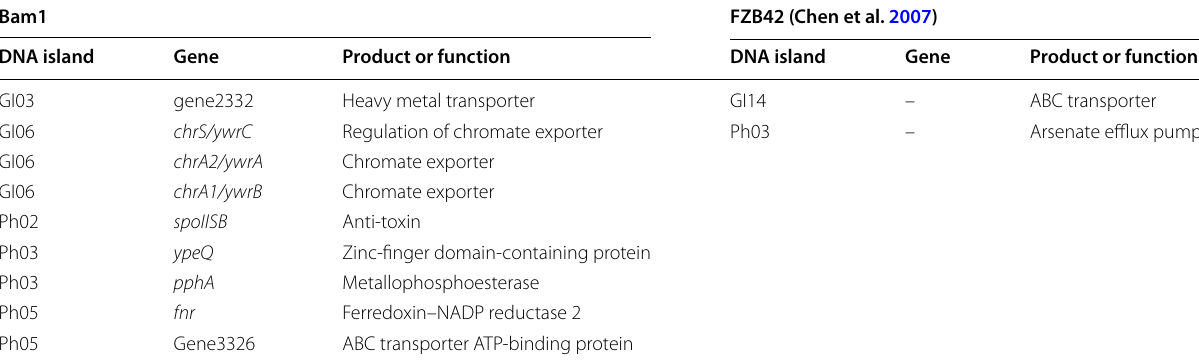
Table 2 Genes involved in heavy metal resistance in the genomic islands (GIs) and prophages (Phs) of the B. amyloliquefaciens strain Bam1 and B. velezensis strain FZB42